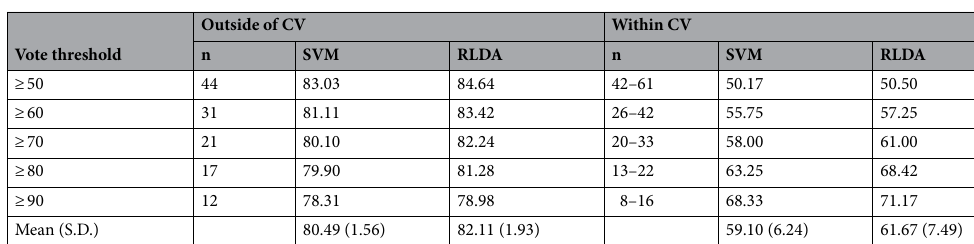
Table 1. Prediction accuracies of the simulation data. Two feature selection approaches (outside of CV and within CV) were tested using two different classifiers (SVM and RLDA, unit: %) with respect to the different vote threshold (number of selected features). n* number of selected features, S.D. standard deviation, SVM support vector machine, RLDA regularized linear discriminant analysis.